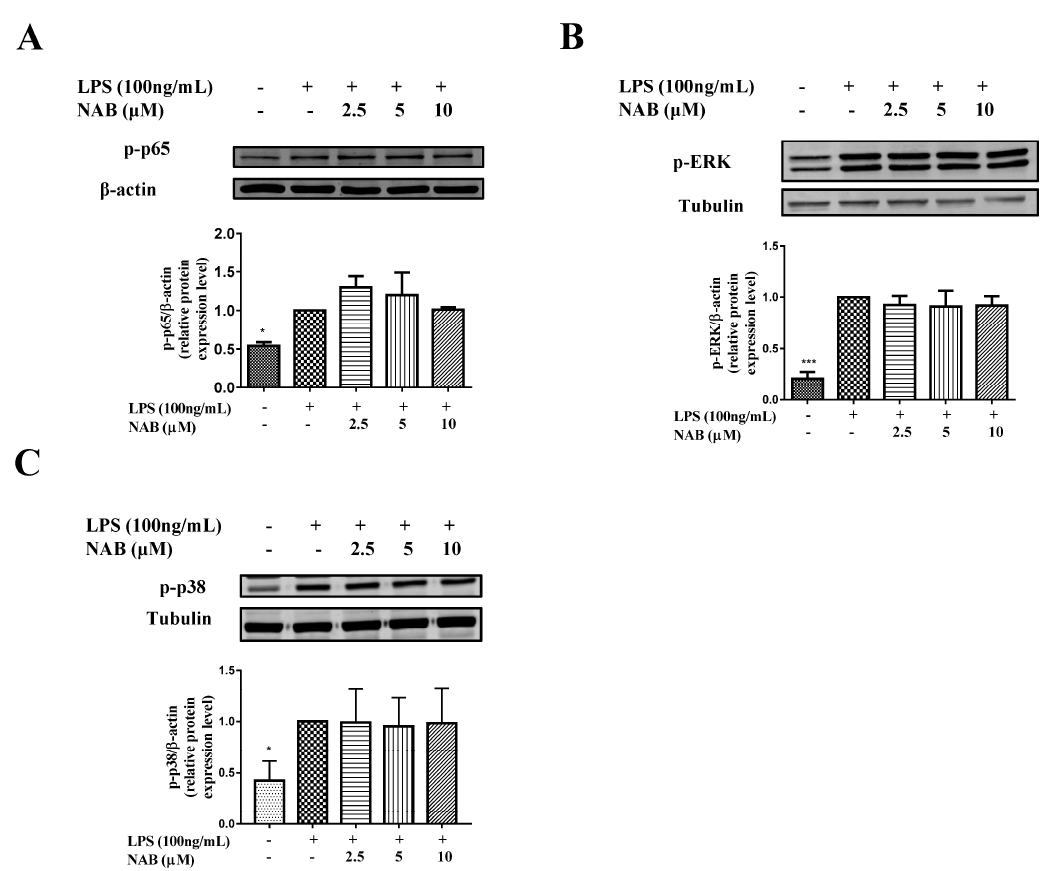
Figure 7. E ff ect of NAB on protein expression level of phospho-p65 (p-p65), phospho-extracellular regulated protein kinase (p-ERK), and phosphor-p38 (p-p38) in LPS-stimulated RAW264.7 cells. Cells were pretreated with NAB for 1 h and then stimulated with LPS (100 ng/mL) for 18 h. The total protein of the cells was collected, and the expression levels of p-p65 ( A ), p-ERK ( B ), and p-p38 ( C ) were analyzed with Western blotting. The density ratio of the LPS group (model control) was set to 1. Results are expressed as the mean ± SEM of three independent experiments. * P < 0.05 and *** P < 0.001 vs. LPS-stimulated cells.